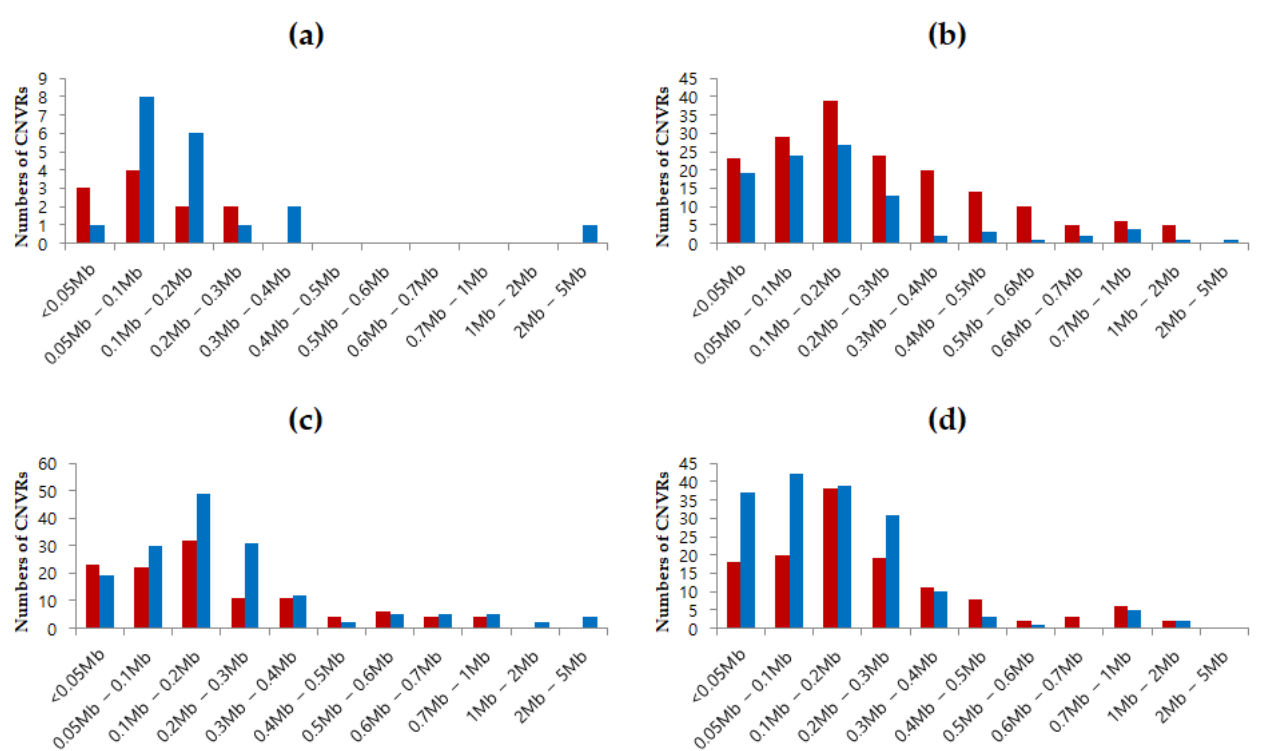
Figure 2. Gain and loss distribution by length of CNV region (CNVR) in four horse breeds in South Korea. ( a ) Jeju horse CNVR distribution; ( b ) Thoroughbred CNVR distribution; ( c ) Jeju riding horse CNVR distribution; ( d ) Hanla horse CNVR distribution. Red and blue represent losses and gains, respectively.